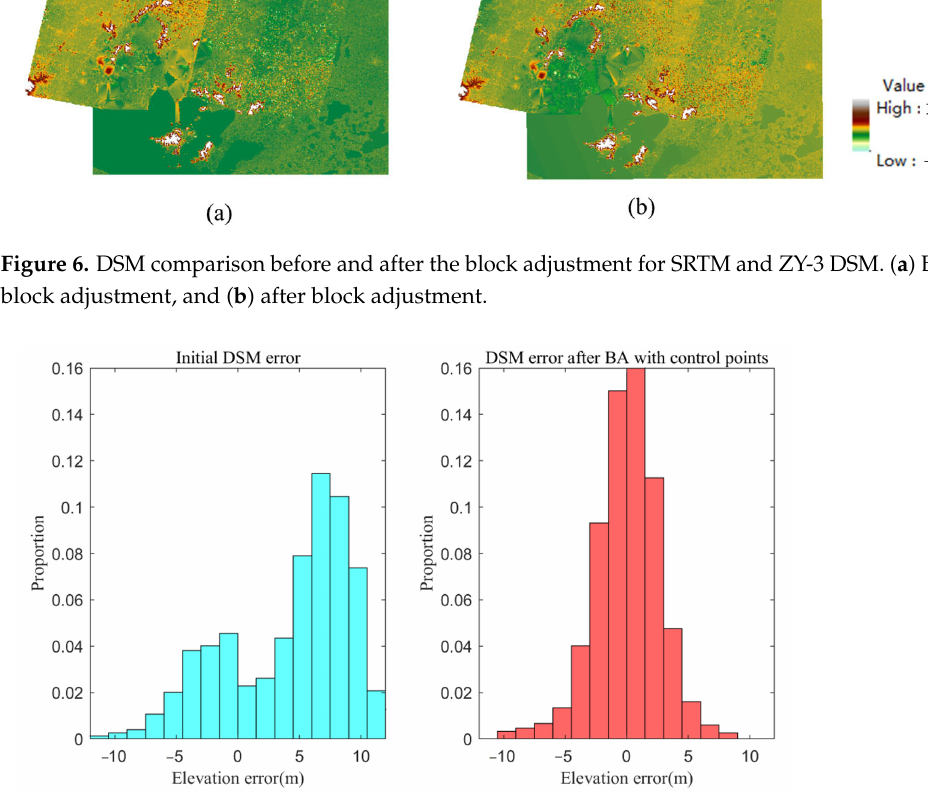
Figure 8. Elevation error distribution on the check points for the SRTM DSMs (positive errors are indicated by the up-pointing red arrows and negative errors by down-pointing blue arrows). ( a ) before block adjustment, and ( b ) after block adjustment. Figures 9 and 10 illustrate the block adjustment results for ALOS DSMs. The eleva- tion error distribution with a mean close to 0 revealed in the histograms demonstrated the effectiveness of the block adjustment. According to the elevation accuracy evaluation re- sults of the checkpoints in Table 3, the ALOS DSMs with higher resolution have a higher initial elevation accuracy of 2.06 m, and the overall improvement of 41% is less noticeable than that of SRTM, 61%. Both the relative elevation errors calculated by the tie-points are reduced to less than 1.5 m after block adjustment. The accuracy of planar location also has a significant improvement after block adjustment, which is within a pixel. The error of check points for ALOS is presented in Figure 11, which also proves the improvement of elevation accuracy after block adjustment, and it can be seen that the initial elevation ac- curacy of ALOS is relatively higher than SRTM. However, due to the difference in sensors, the elevation of the DSM overlapping region is not as consistent as that of the homolo- gous-source DSMs. Additionally, due to the lack of texture and various imaging